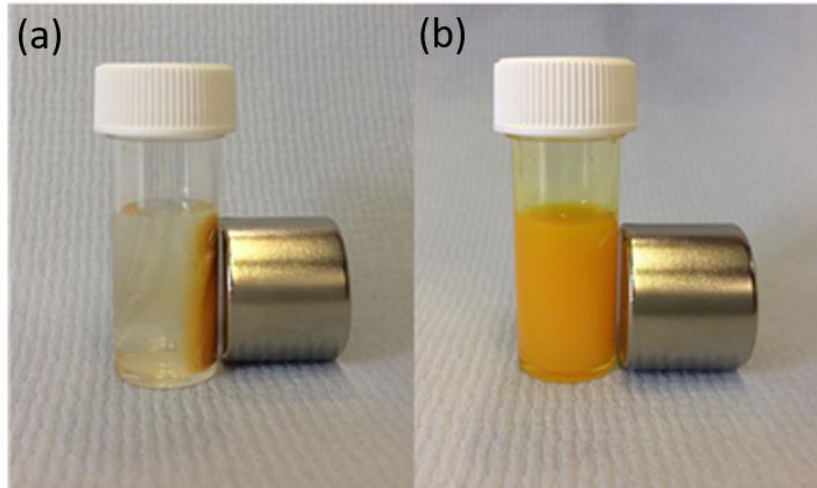
Figure 4. CMACPs were prepared by suspending MACPs in CUR water/DMSO solution and incubating for 24 h under stirring. The resulting CMACPs can be rapidly collected by a Neodymium magnet (pull force 25 Kg, 25.4 mm diameter × 30 mm thick) within 1 min ( a ). The free CUR in solution on the other hand was not affected by the magnetic force ( b ).